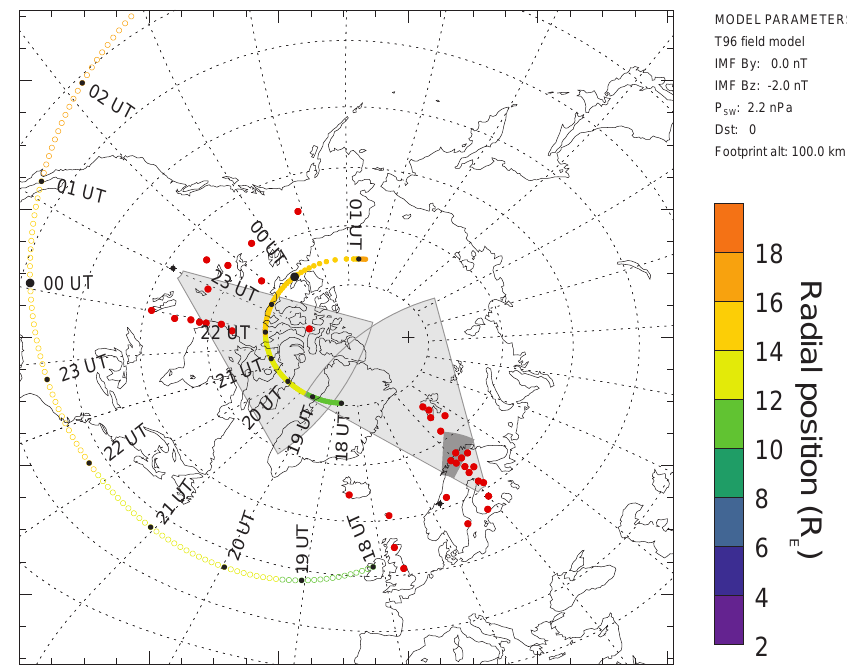
Fig. 1. Ground track of Cluster 1. Filled dots indicate the magnetic footprint, traced with the Tsyganenko (1996) field model, whilst unfilled dots indicate the radial projection of the Cluster 1 tra- jectory, colour coded with the satellites radial position. Also shown are the locations of the CANOPUS, IMAGE and SAMNET magnetometers, along with the fields of view of the CUT- LASS Finland and Saskatoon Super- DARN radars, as well as that of the STARE Norway